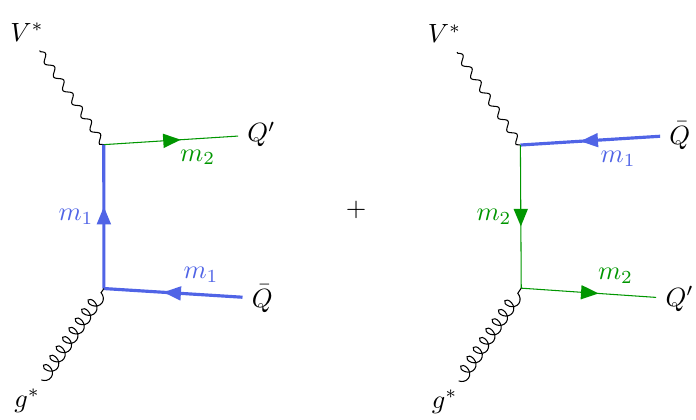
Figure 7 . Diagrams entering the computation of the DIS coe(cid:14)cient function with o(cid:11)-shell incoming gluons at lowest order. The (o(cid:11)-shell) vector boson can either be a photon, a Z or a W . In the latter case, the quark changes (cid:13)avour after interacting with it, and thus does the mass. Note that, in practice, the charged-current case is relevant only if one of the two quark is massive and the other massless. Indeed only charm, bottom and top masses cannot be neglected, but the top contribution to DIS is always negligible. Therefore, the only processes for which two di(cid:11)erent non-zero masses would be needed are c + W ! b and b + W ! c . But these processes are suppressed by the CKM matrix element V 4 10 (cid:0) 2 , and by the phase-space restrictions due to the quark masses. Therefore, the